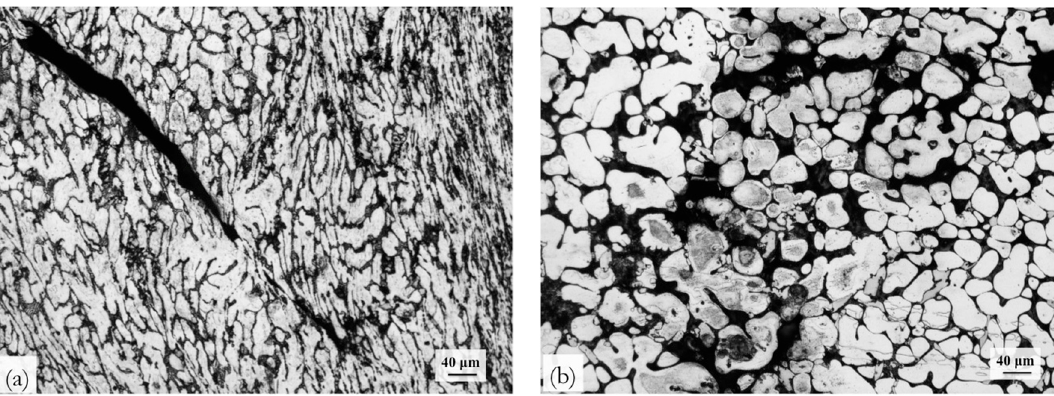
Figure 14. Optical microstructures of the ABaX633 alloy forged at conditions correspond to flow instability in the processing map: ( a ) 300 °C/10 mm·s − 1 and ( b ) 500 °C/10 mm·s − 1 . Forging axis is vertical.